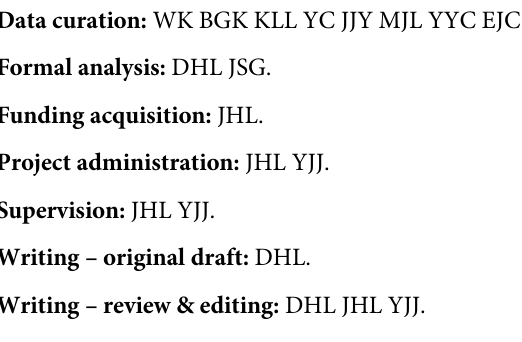
S1 Table. The new modified CTP (IGF-CTP) classification. S2 Table. Patient distribution in the cohort for IGF-CTP class by CTP class. S3 Table. Adjusted Cox model results for overall survival of the cohort based on insulin- like growth factor